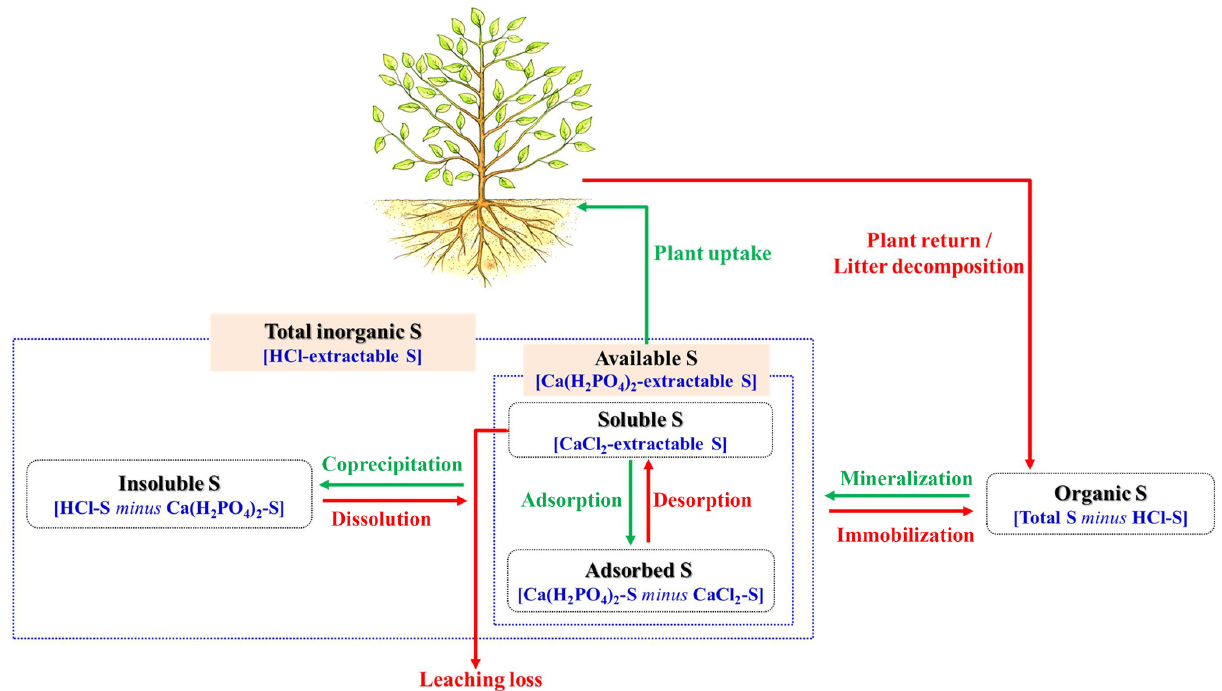
Figure 1. Conceptual scheme depicting the transformation of sulfur (S) fractions in aerobic calcareous soils. Arrows indicate processes affect- ing the concentration of one S fraction, with green and red colors representing opposite transformation processes. Below each S fraction, char- acters in blue indicate that the S fraction was directly measured from the extraction or indirectly calculated from analyzed fractions. Specif- ically, soluble S (CaCl 2 − ), available S (Ca ( H 2 PO 4 ) 2 − S), and total inorganic S (HCl-S) were directly extracted by CaCl 2 , Ca ( H 2 PO 4 ) 2 , and HCl, respectively. Adsorbed S was calculated by Ca ( H 2 PO 4 ) 2 − S minus CaCl 2 − S, insoluble S by HCl-S minus Ca ( H 2 PO 4 ) 2 − S, and organic S by total S minus